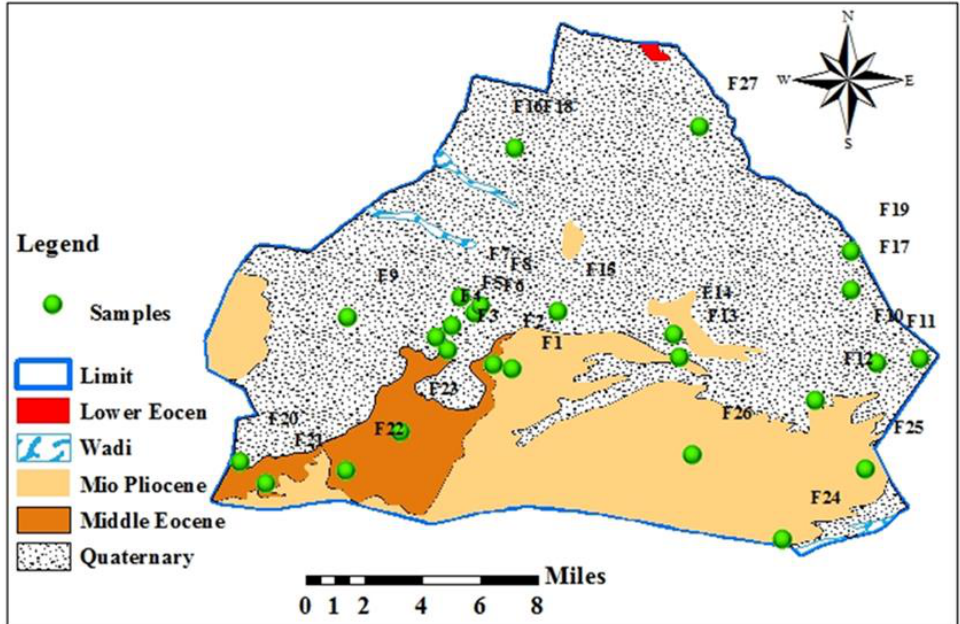
Figure 2. Geological map of the Doucen plain,